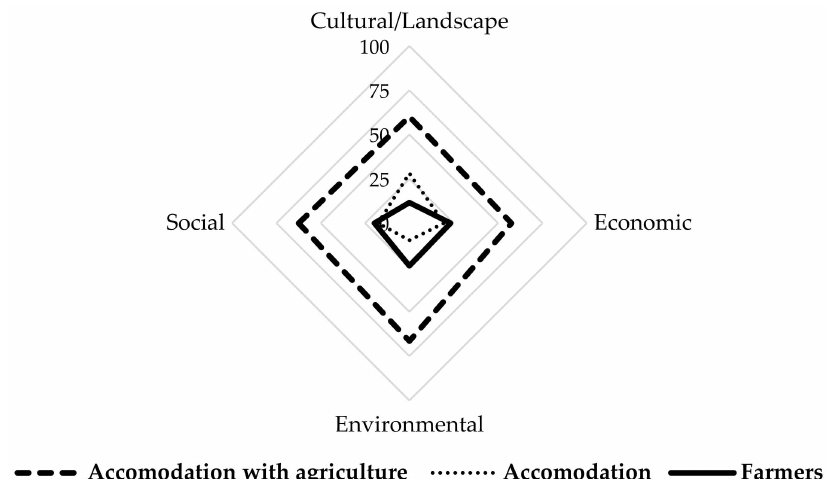
Figure 3. A comparison of sustainable indicators between accommodation, accommodation with agricultural activity, and farmers (% of total implemented actions).